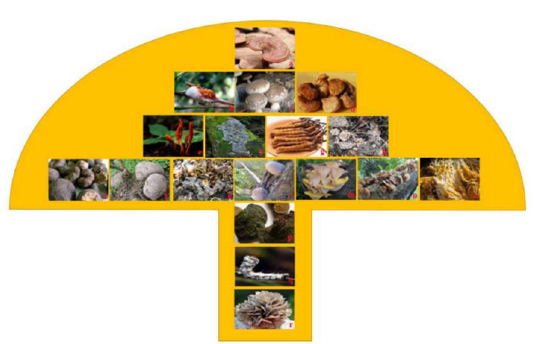
Figure 3. The medicinal fungi involved in this review, a-f are Ganoderma lucidum , Shiraia bambusicola , Lentinus edodes , Hericium erinaceus , Cordyceps militaris , Coriolus versicolor , Cordyceps sinensis , Schizophyllum commune , Omphalia lapidescens , Poria cocos , Polyporus umbellatus , Cryptoporus volvatus , Pleurotus citrinopileatus , Auricularia auricula , Flammulina velutipes , Phellinus igniarius , Beauveria bassiana , and Grifola frondose .